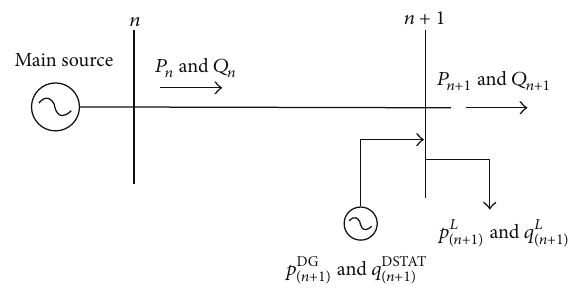
Figure 1: Single-line diagram of a two-bus